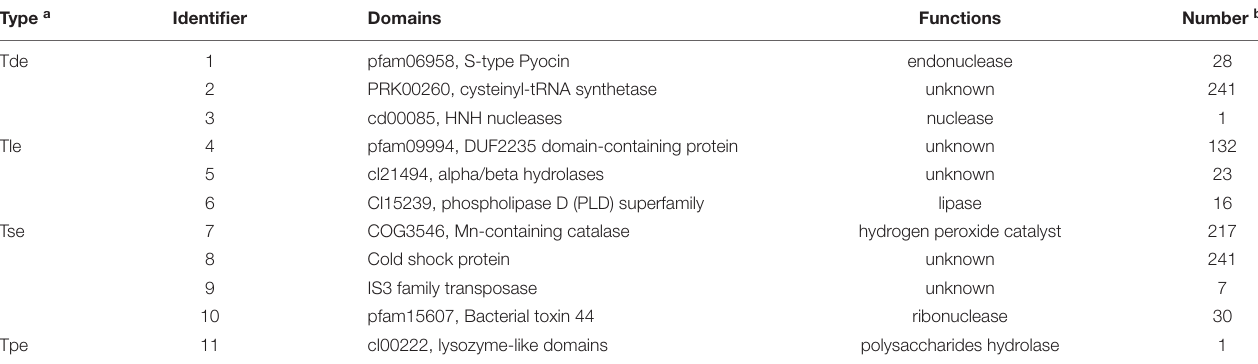
TABLE 1 | Putative effectors in K. pneumoniae.